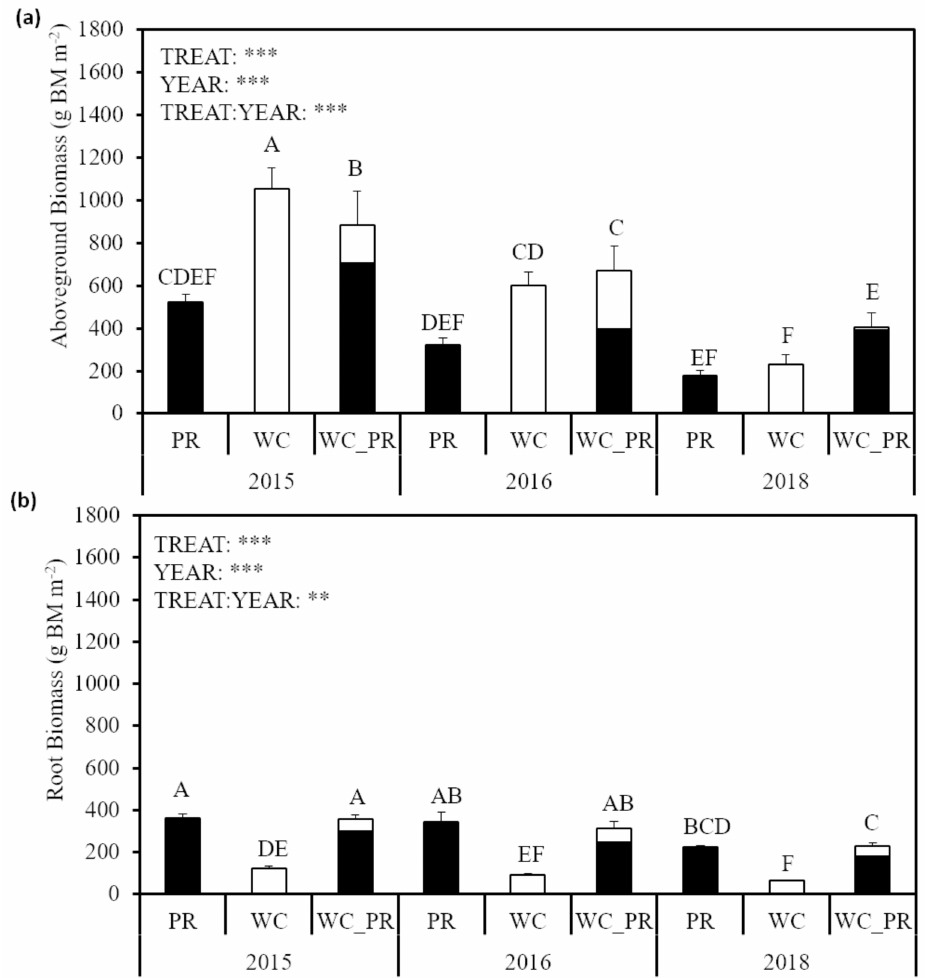
Figure 1. ( a ) Aboveground biomass and ( b ) root biomass (0–60 cm) in 2015, 2016, and 2018 of monocultures of unfertilized perennial ryegrass (PR) and white clover (WC) and white clover– perennial ryegrass mixtures (WC_PR). Shown are means and standard errors averaged over all eight genotypes with four replicate samplings ( n = 4). The results of the mixed models on the significance of the effect of the cultivated crop (TREAT) and year (YEAR) are indicated by asterisks (*** for p ≤ 0.001). Different uppercase letters indicate significant differences (** p ≤ 0.05, LSD post hoc test) between different treatments and